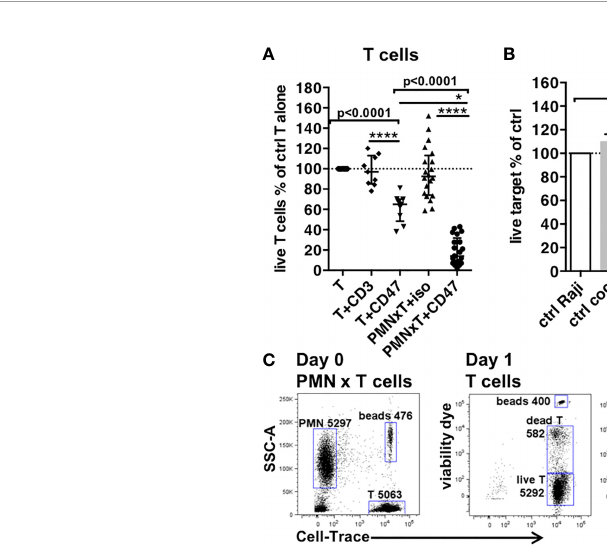
FIGURE 1 | Anti-CD47 mAbs induce killing of primary T cells by PMNs. (A) Cytotoxicity to primary T cells induced by anti-CD47 mAb clone CC2C6 alone or in the presence of PMNs (n = 9 – 25 different donors; ratio of PMN to T cells = 2). Iso, isotype; CD3, anti-CD3 mAbs; CD47, anti-CD47 mAbs. (B) Induction of PMNs ’ cytotoxicity to Raji lymphoma B cells by combinations of Rituximab (RTX) plus anti-CD47 mAb clone CC2C6 (CD47) (n = 3; ratio of PMN to target = 3). For (A, B) , cytotoxicity is represented by the % of live targets in indicated conditions compared to targets cultivated overnight alone. Median and IQR (interquartile range) are shown. P -values from Kruskall – Wallis test is indicated on top of groups, P -values from Dunn ’ s multiple comparison post-test on top of pairs: * P < 0.05; ** P < 0.01; **** P < 0.0001. (C) Cytotoxicity assay. The left plot shows the coculture of PMN with Cell-Trace stained T cells on day 0. The following plots show cell-trace and viability staining of indicated cocultures after overnight incubation. Gates and counts of beads, live and dead Cell-Trace – stained T cells are